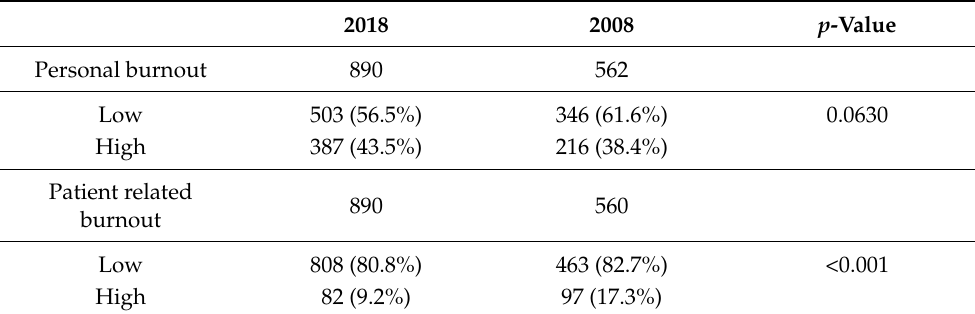
Table 1. Analysis comparing SESMAT population to REPAR study sample.